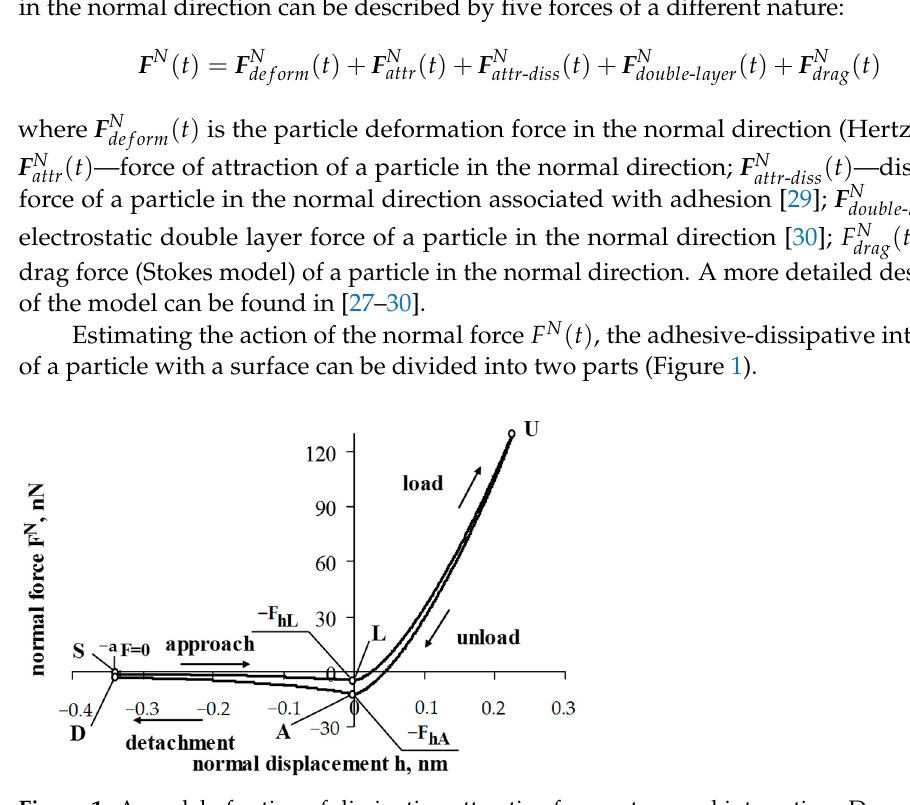
Figure 1. A model of action of dissipative-attractive forces at normal interaction. Dependence of normal force and displacement.